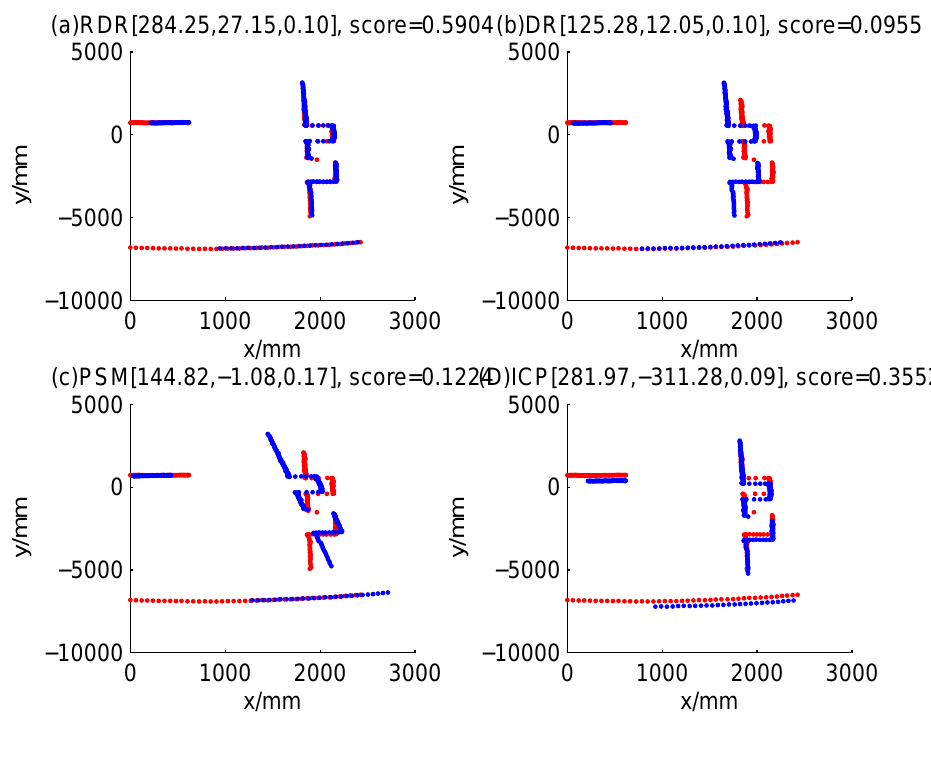
Figure 20. Robust dead reckoning result for case 3b (time step 13).